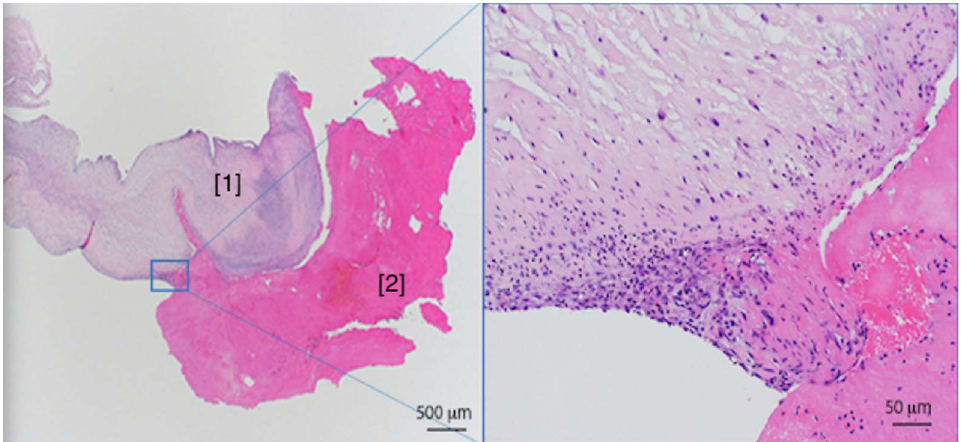
Figure 4. Histological examination. Histological examination of the excised aortic valve (hematoxylin and eosin stain) shows a florid inflammation consisting mainly of neutrophilic leucocytes. [1] Leaflet and [2] attached fibrinous material.